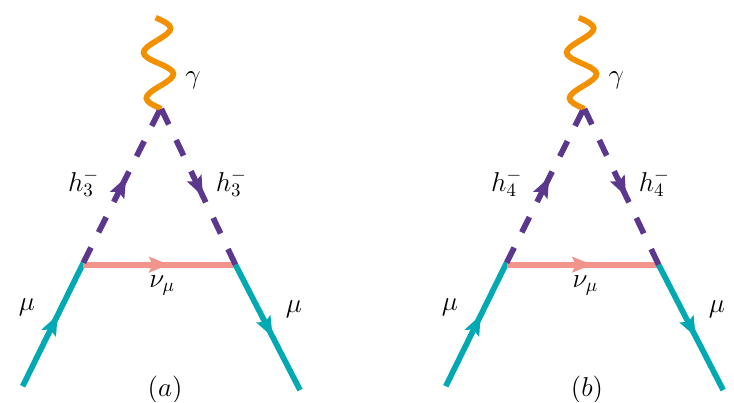
Figure 3 . Feynman diagrams for the interaction of singly charged scalars h (cid:0) contributing to the muon anomalous g